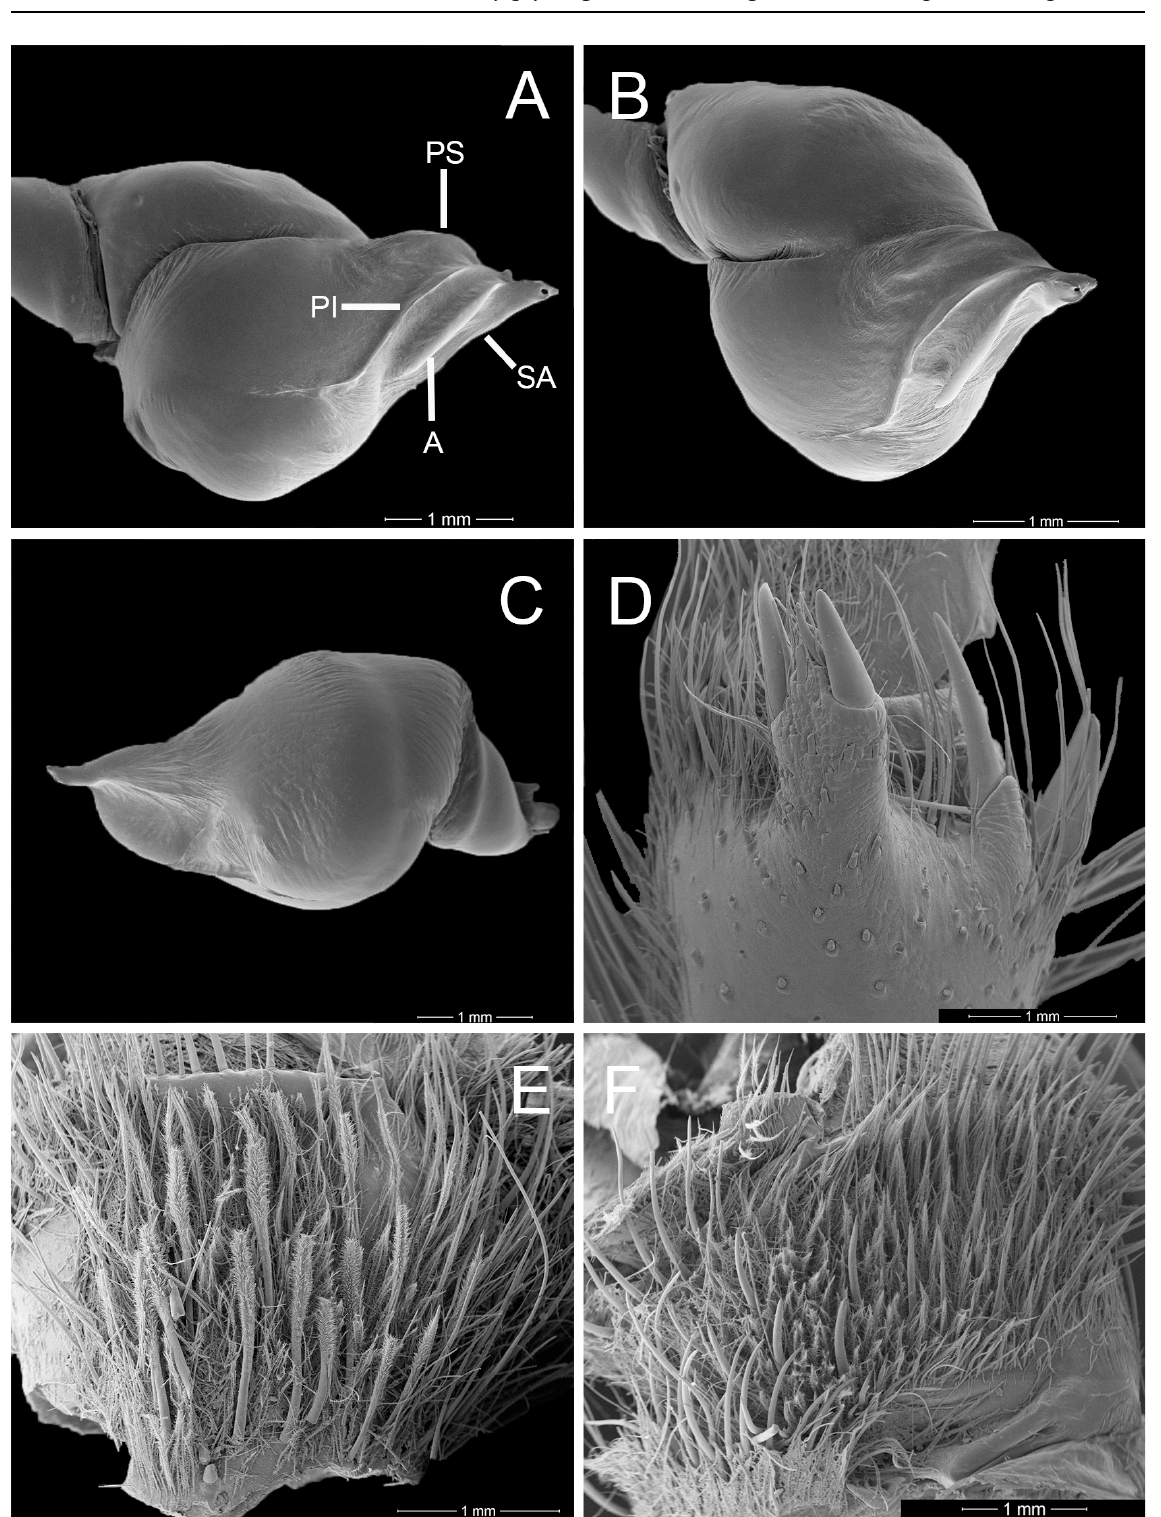
Fig. 28. Umbyquyra caxiuana gen. et sp. nov., holotype, ♂, Floresta Nacional de Caxiuanã, Pará, Brazil (MPEG 0967). A . Palp, prolateral. B . Anterolateral. C . Retrolateral. D . Tibial apophysis, retrolateral. E . Stridulatory organ, trochanter. F . Same, trochanter I. Abbreviations: see Material and